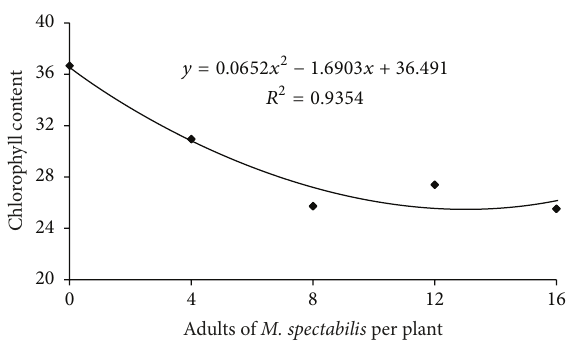
Figure 1: Relationship between infestation levels of adult M. spectabilis and chlorophyll content (SPAD unit) in B. ruziziensis .